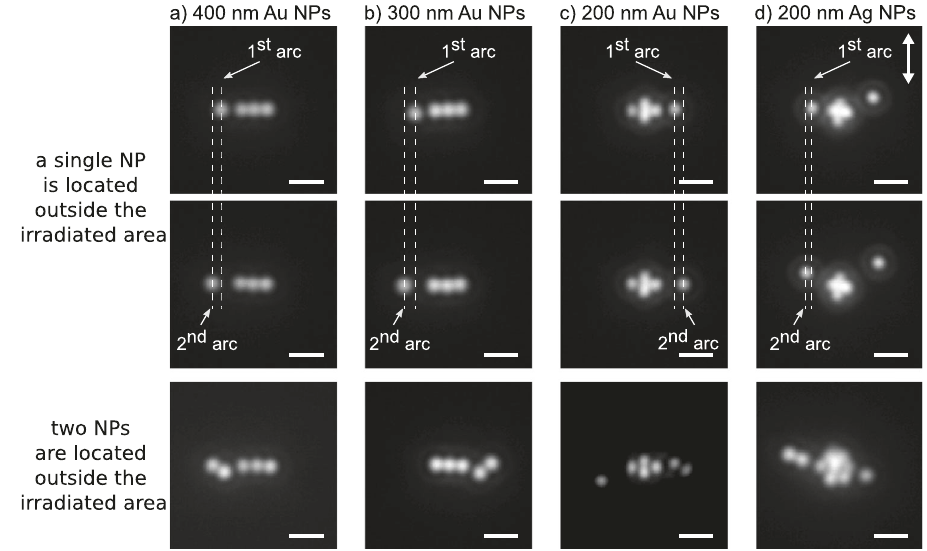
Fig. 6 | Representative scattering images, when 1 or 2 NPs are located outside the irradiated area. The white scale bar is 2 μ m, and the white double-pointed arrow indicates the direction of the laser linear polarization. Used NPs: ( a ): 400nm Au NPs, ( b ): 300nm Au NPs, ( c ): 200nm Au NPs, and ( d ) 200nm Ag